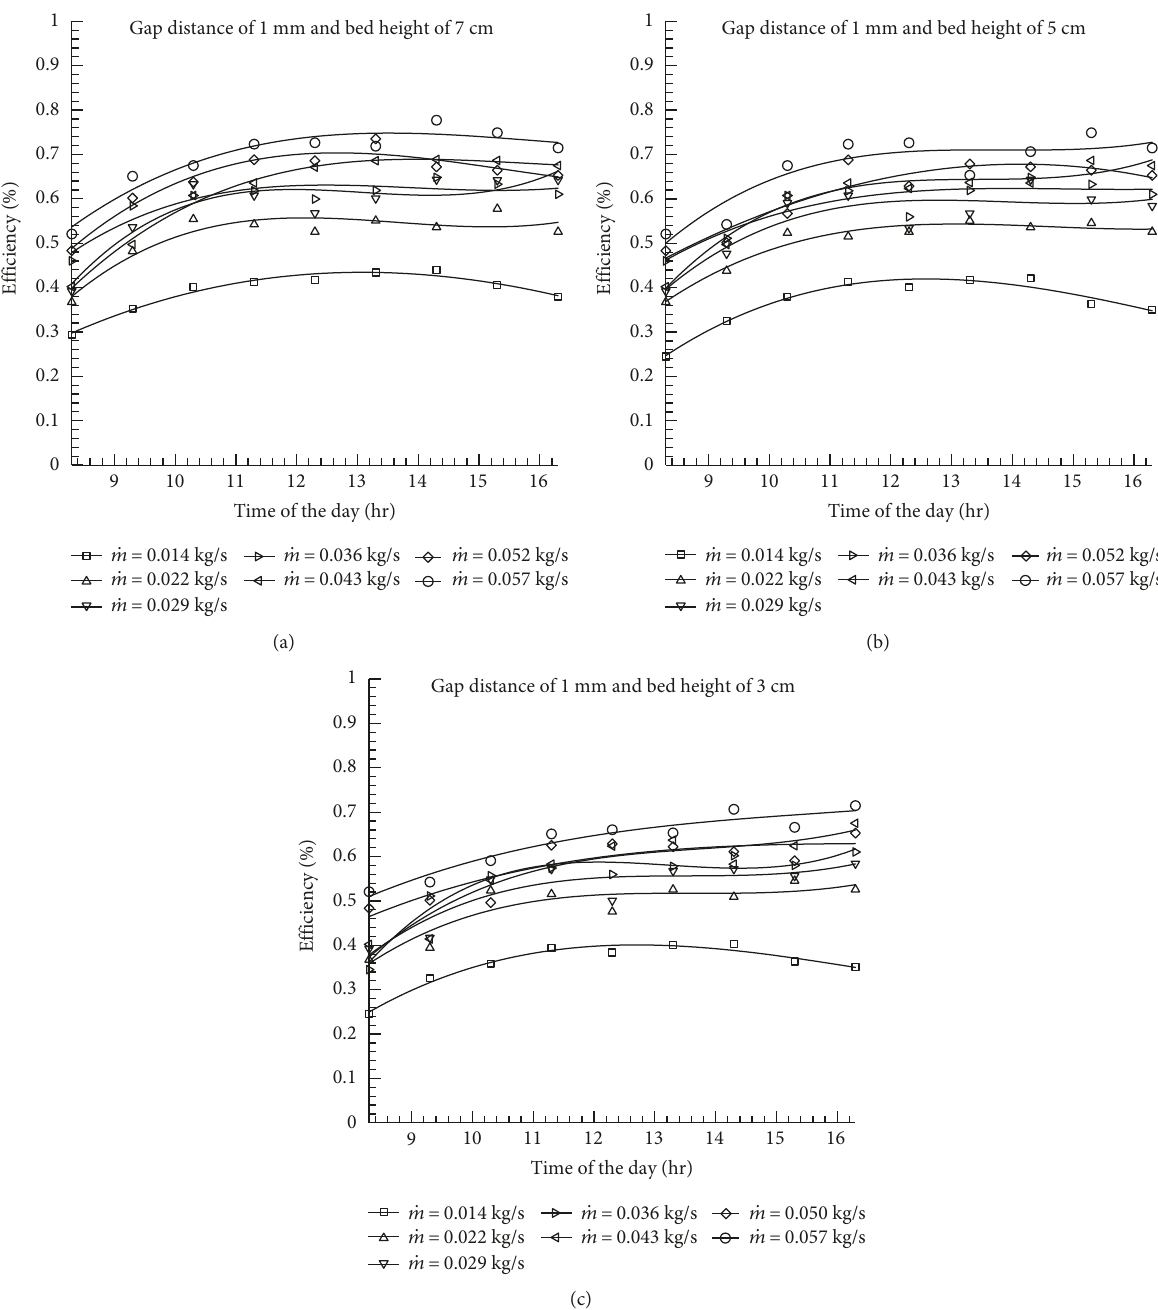
Figure 9: Thermal e ffi ciency versus time at the gap distance of 1mm for bed heights (a) 7cm, (b) 5 cm, and (c) 3 cm and di ff erent mass fl ux